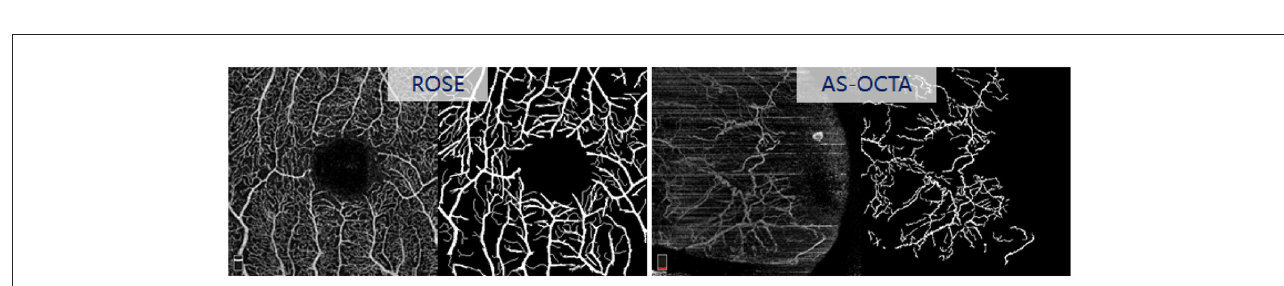
FIGURE6 Original OCTA images and their vessel manual annotations in ROSE and AS-OCTA dataset.